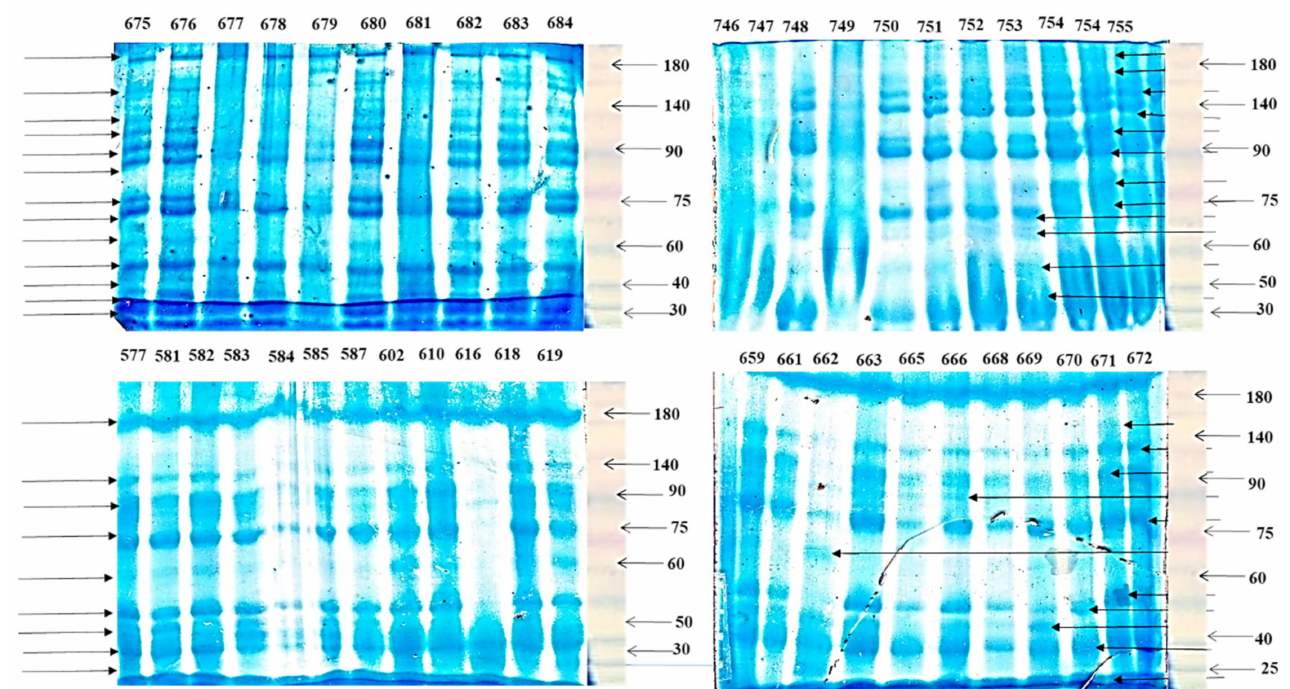
Figure 5. The gel picture shows polymorphic subunits of different Oat ( Avena sativa ) genotypes of the present